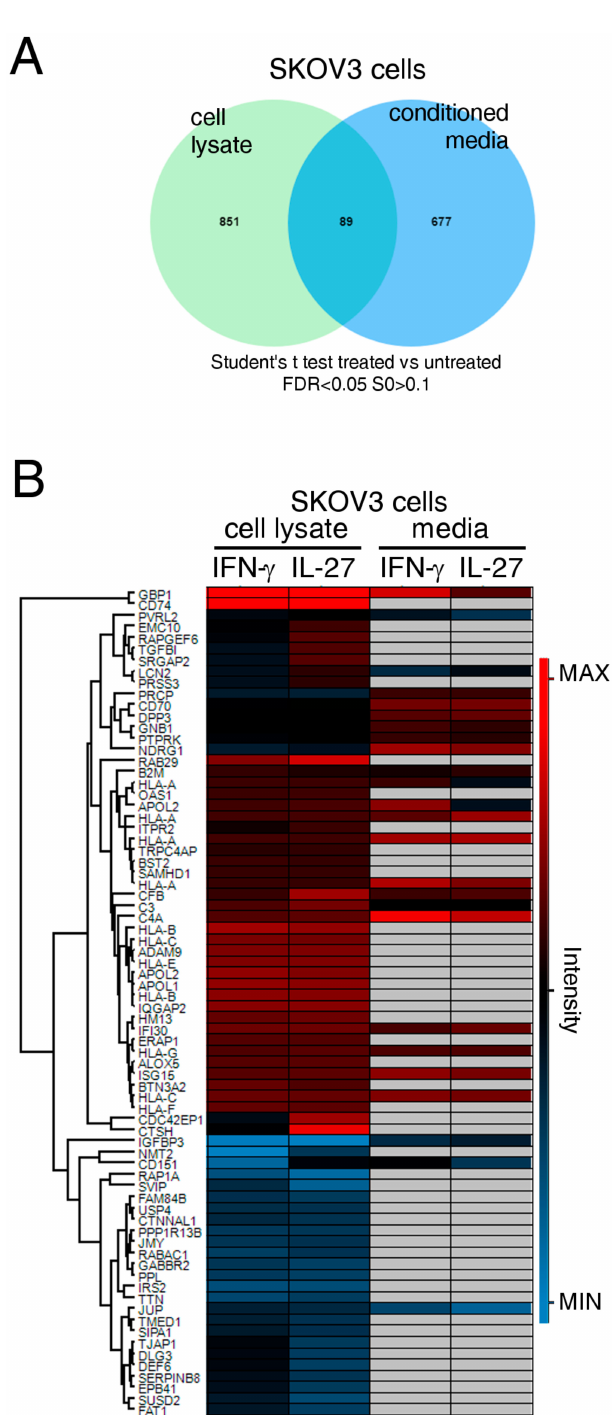
Figure 2. Comparison between the cellular proteome and the secretome of cytokine-stimulated SKOV3 cells. ( A ) The Venn diagram (2 A ) shows the comparison between the t-test significantly modulated proteins (FDR < 0.05 S0 > 0.1 versus untreated) in cell lysates versus conditioned media of SKOV3 cells, under the same treatment conditions (IL-27 or IFN- γ ). ( B ) The fold-change heatmap shows the combination of further filtering t-test data applying a fold change > 4, intersected with the gene ontology of the cellular component associated with the extracellular matrix. The new selection leads to the global identification of 74 cytokine-modulated proteins in the cell lysate, while only 25 are shared with the